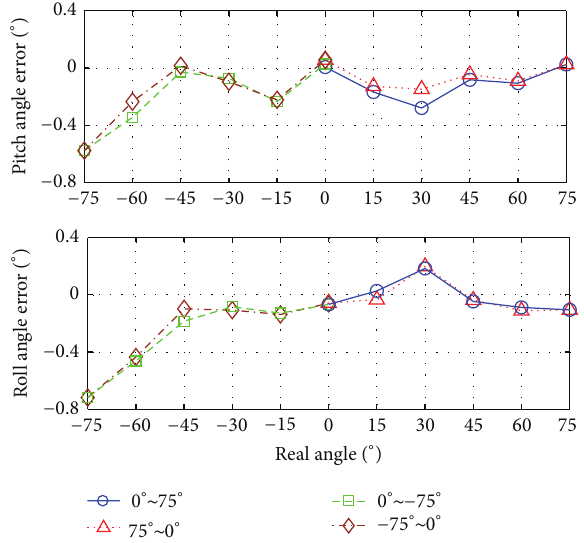
Figure 6: Static precision test of pitch angle and roll